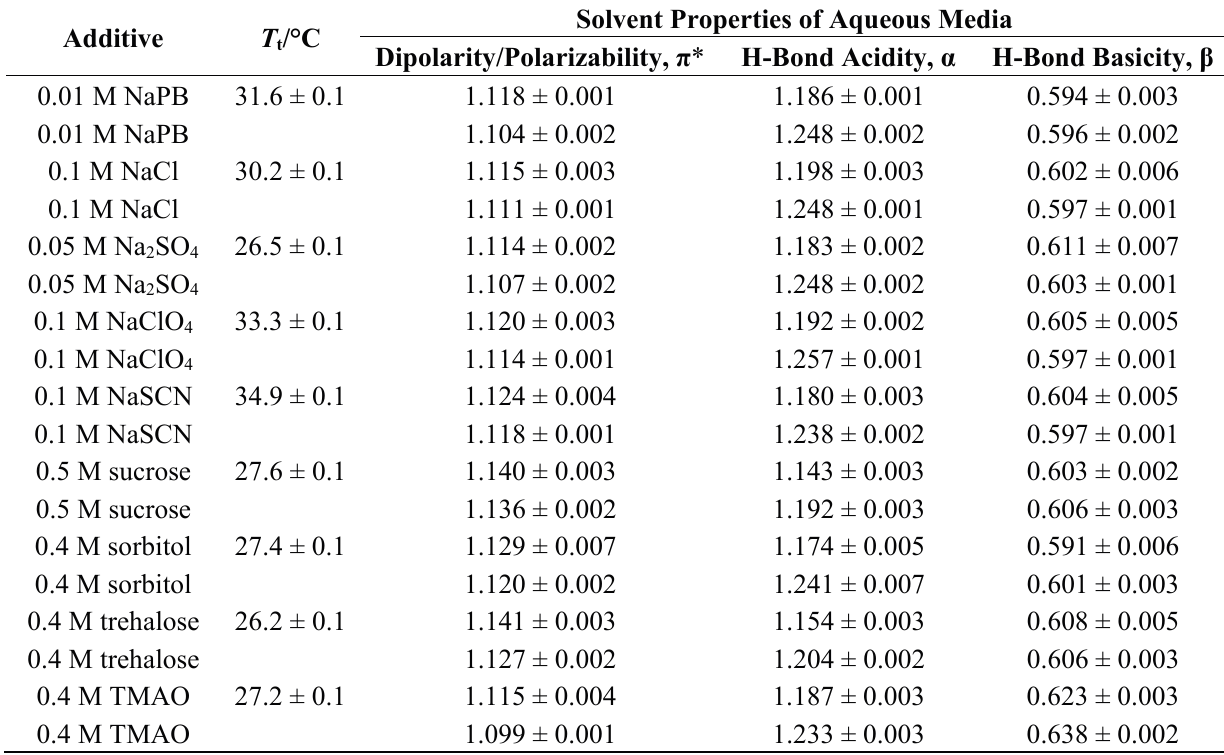
Table 1. Solvent properties π * , α , and β of aqueous media in 10 mM sodium phosphate buffer at pH 7.4 in the presence of different additives and phase-transition temperature, T t , as well as solvent properties in solutions of 0.90 mM ELP in the presence of additives * . Solvent Properties of Aqueous Additive T /°C t